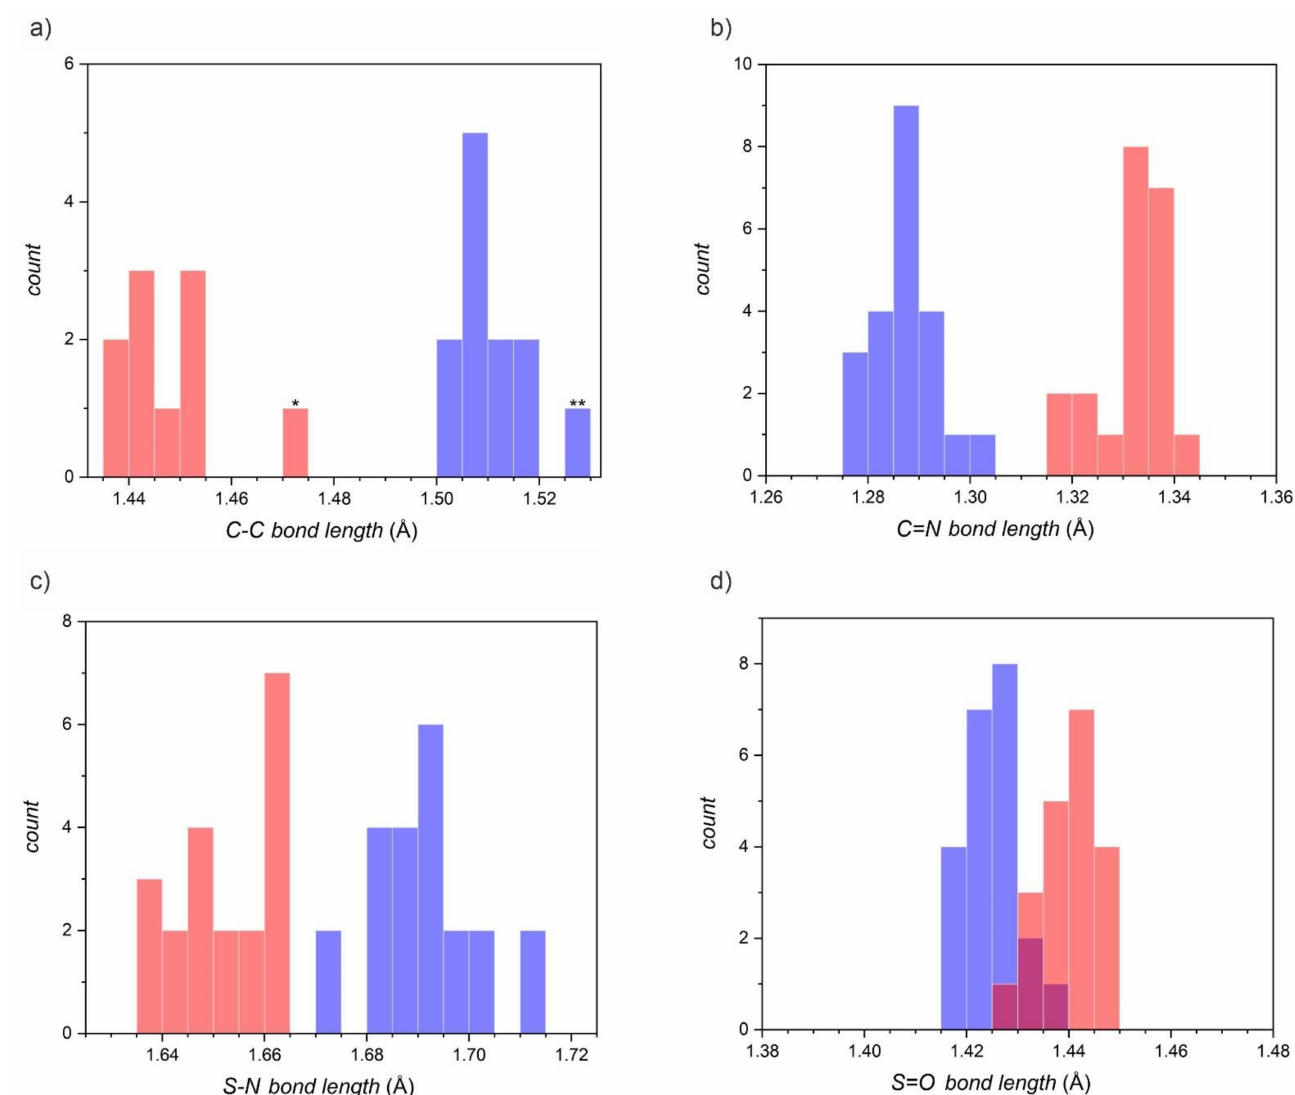
Figure 2. Histograms presenting the distribution of bond lengths in the dioxothiadiazole rings: ( a ) C-C, ( b ) C=N, ( c ) S-N, and ( d ) S=O, depending on the valence state: neutral (blue bars) or radical anion (red bars). Note that each plot has the same bond length axis range of 0.1 Å and the bars correspond to 0.005 Å (outsiders in the C-C distribution: *crystal structure VITSAU, ** crystal structure